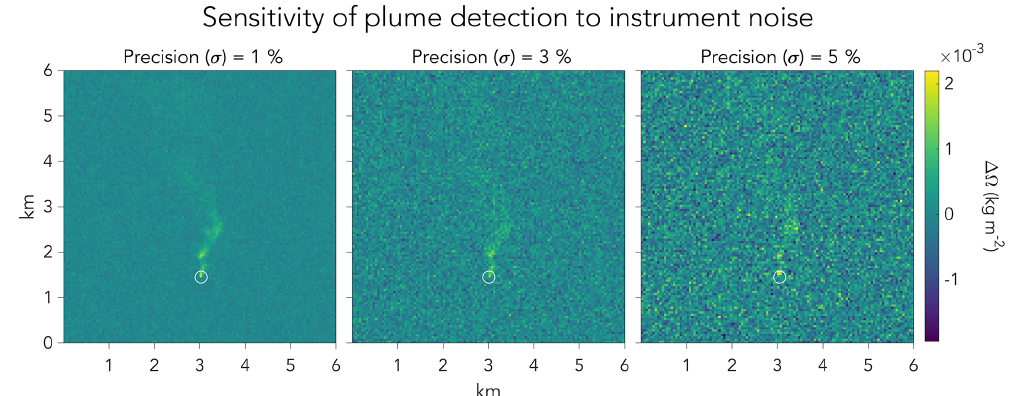
Figure 1. Examples of column plume pseudo-observations generated by an LES on a 50 × 50m 2 grid. The circle identifies the location of the source. Each panel shows the same synthetic plume observation for a source Q = 1th − 1 , with instrument precision σ varying from 1% to